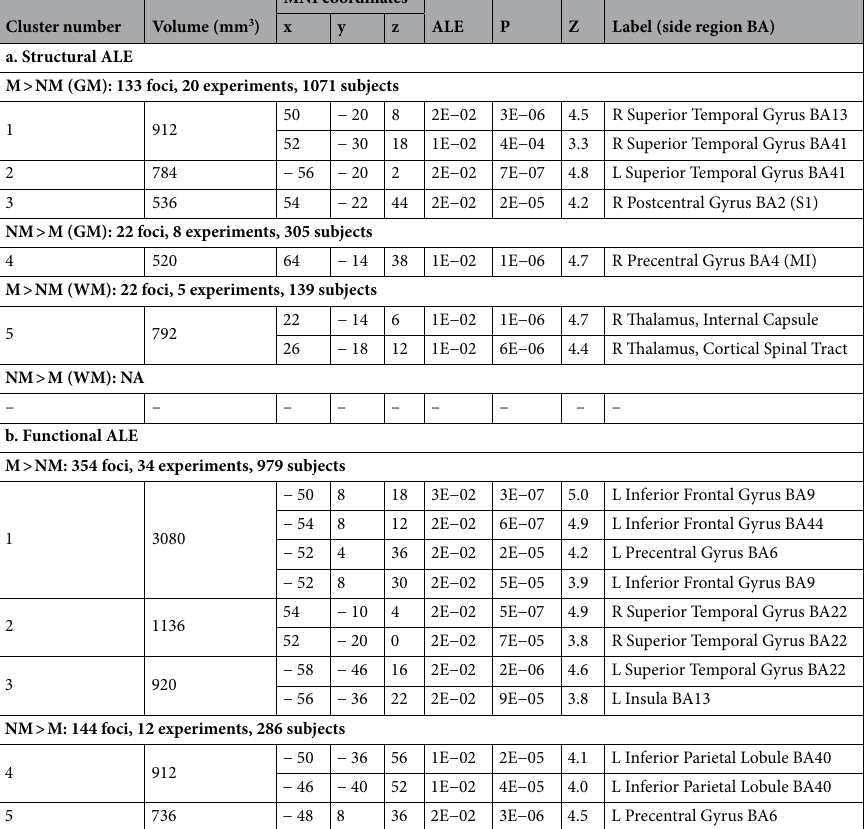
and auditory perception; and experimental paradigms including finger tapping, passive listening, visuospatial attention, and oddball, tactile, and tone discrimination. The right precentral gyrus ROI (Fig. 2d) showed co-activation with claustrum and insula. Relevant behav- ioural domains within its boundaries include execution, attention, speech, temporal processing, and emotional processing; and experimental paradigms including finger tapping and visuospatial attention. The right internal capsule ROI (Fig. 2e), including the right thalamus as the nearest grey matter, showed co- activation with left thalamus, right medial frontal gyrus, right insula, and left cerebellum. Relevant behavioural domains within its boundaries include execution, speech, attention, memory, reasoning, emotion, reward, and auditory perception; and experimental paradigms including emotion induction, finger tapping, passive listening, reward, and tone discrimination.